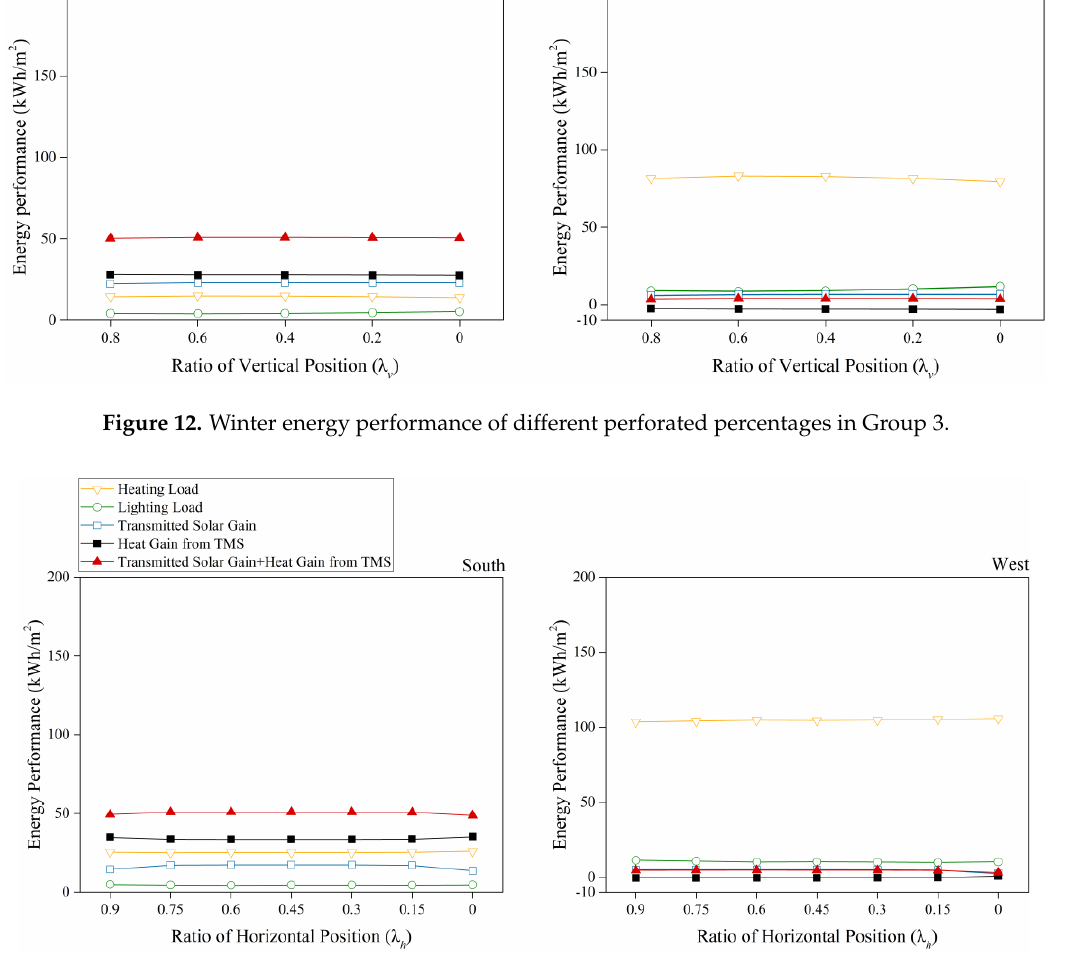
Figure 13. Winter energy performance of different perforated percentages in Group 4.